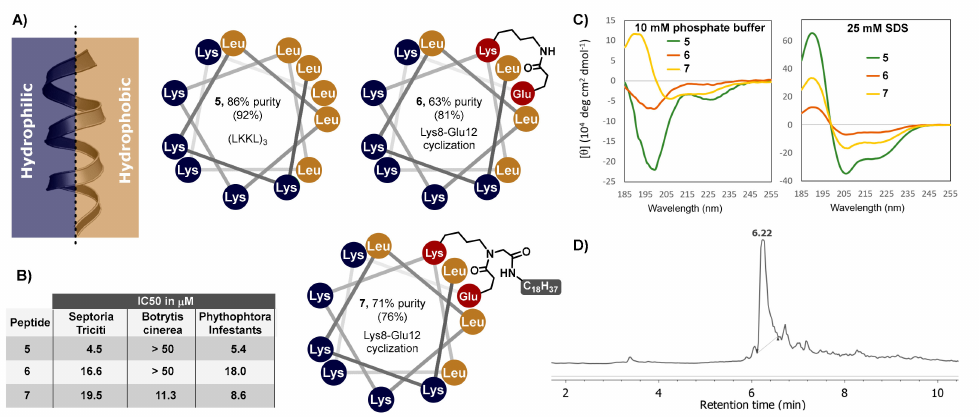
Figure 1. ( A ) Helical wheel representation of the structure of peptides 5-7 designed to possess an ideal amphiphilic structure. In parenthesis the yields of crude products; an analytical sample was purified to > 93% purity; ( B ) Bioactivity of the compounds against model phytopathogens; ( C ) CD spectra for the peptides in 10 mM phosphate bu ff er and 25 mM SDS aqueous solutions; ( D ) UHPLC-MS chromatogram of crude peptide 7